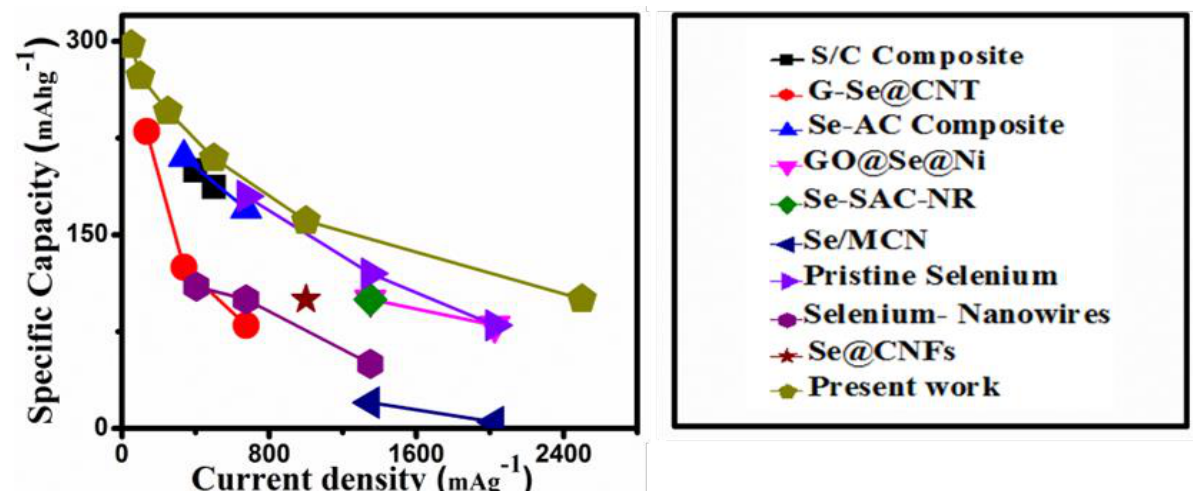
Figure 4. Comparison of current work (rate performance) with that of previously discussed results [15, 20,32‐37] on Li‐Se battery.